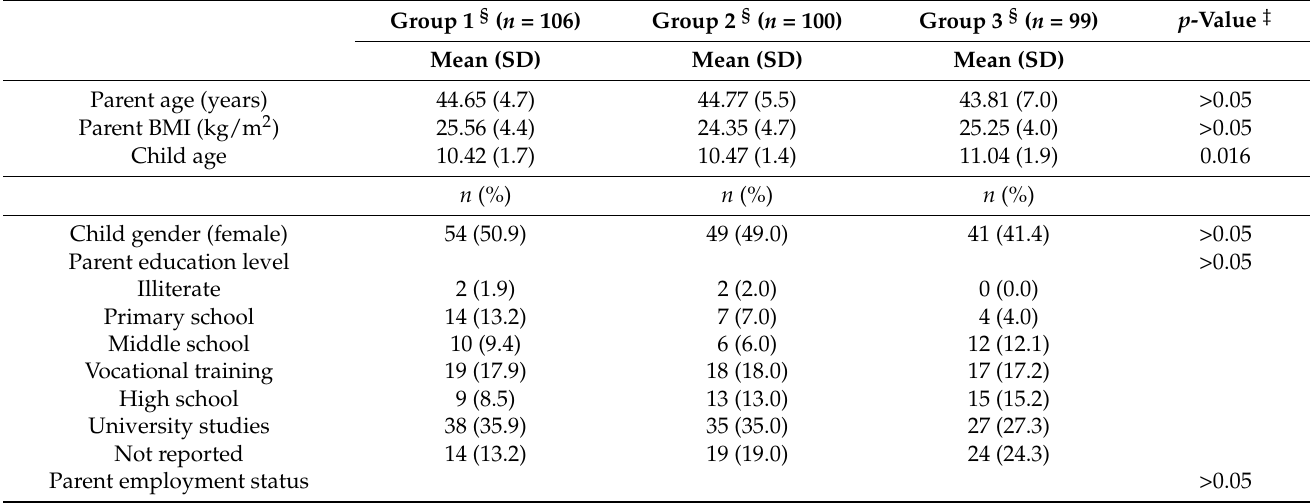
Table 1. Sociodemographic characteristics of parents and children according to health-related quality of